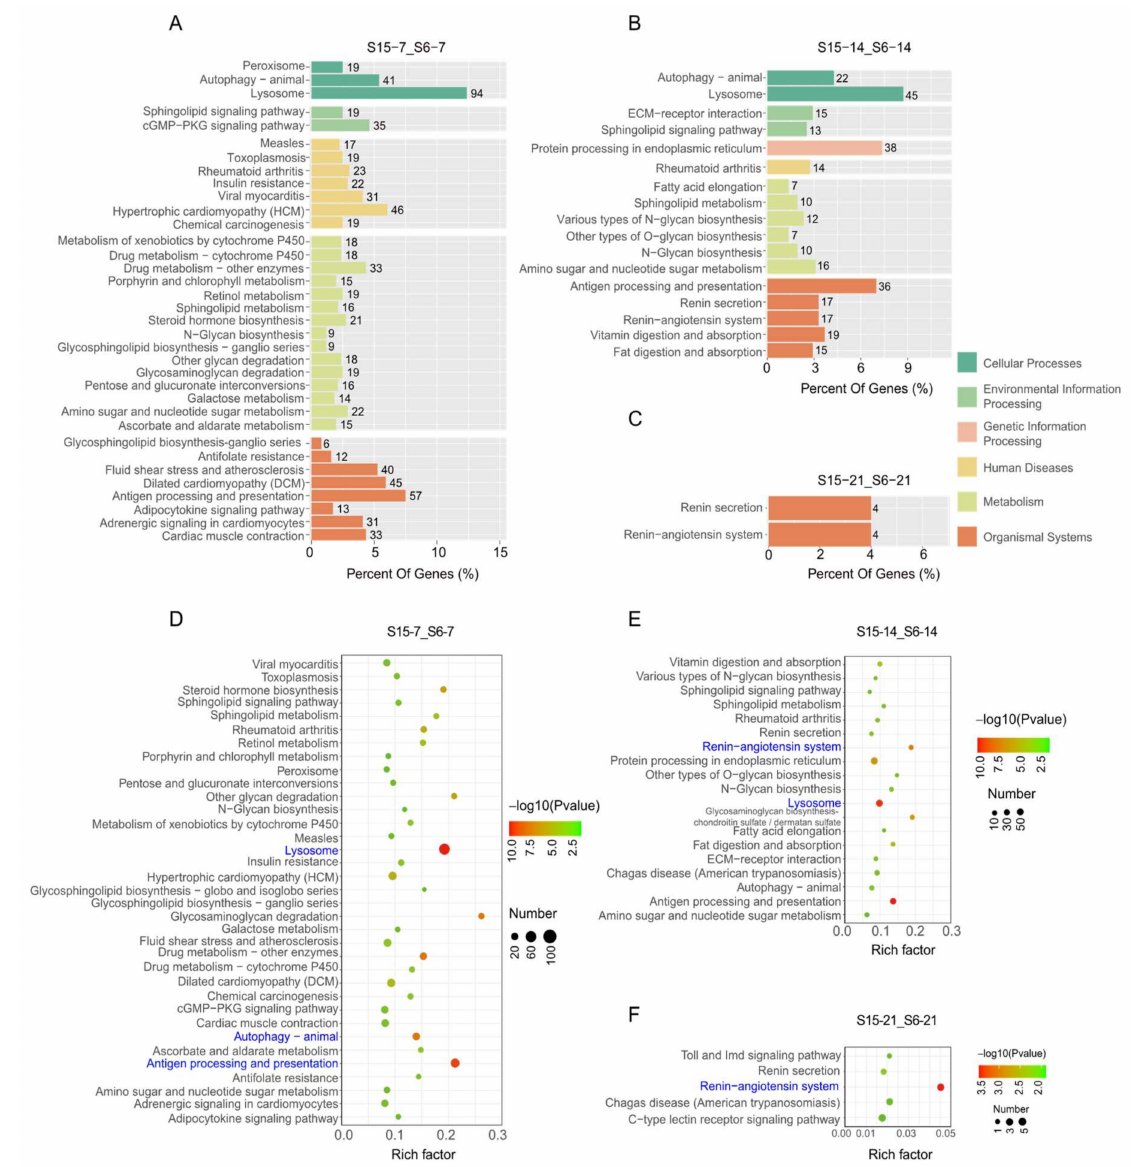
Figure 4. Enriched KEGG pathways for DEGs in M.rosenbergii post-larvae under hypotonic stress at different development stages. Note: ( A – C ): KEGG pathways involved in different categories at 7 dph, 14 dph, 21 dph larvae; ( D – F ): The most significant enrichment KEGG pathways at 7 dph, 14 dph, 21 dph larvae. S6-7: 7 day-post-hatch larvae in 6 psu salinity; S15-7: 7 day-post-hatch